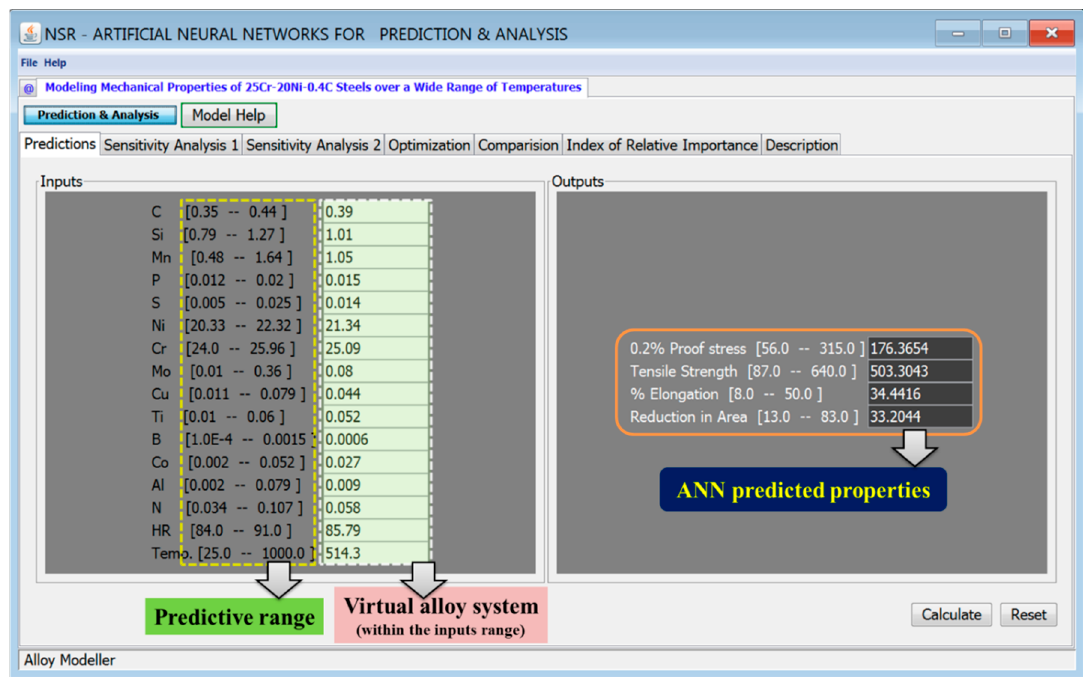
Figure 7. The screenshot of the ANN model shows the prediction of mechanical properties of a virtual 25Cr-20Ni-0.4C steel by using mean values of all input variables. Within the predictive range of the inputs, there are millions of combinations of experiments possible, of which the model can predict with reasonable accuracy.